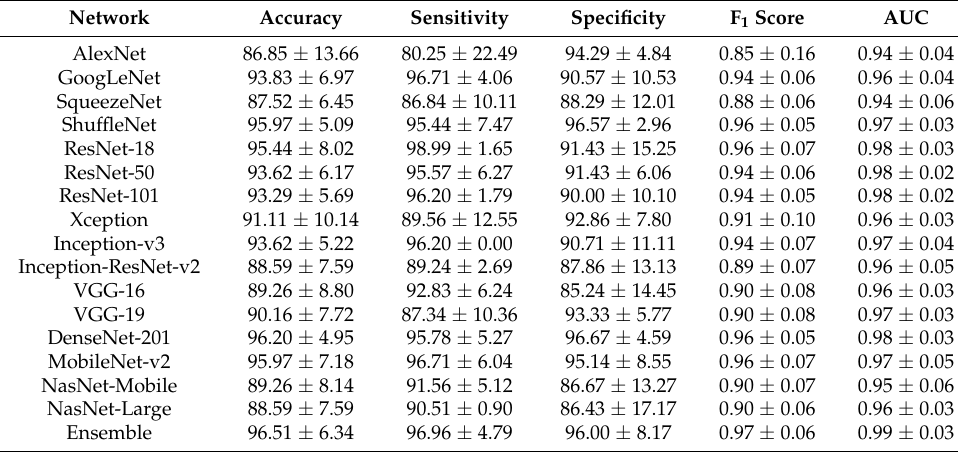
Table 4. Classification results without data augmentation.